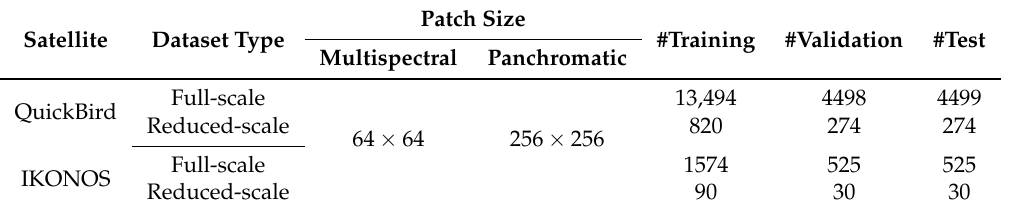
Table 4. Details of